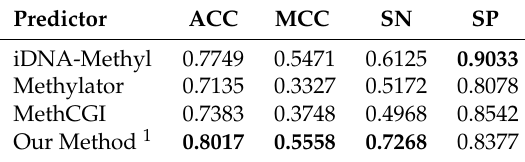
Table 3. Comparison of our method, MethCGI, Methylator, and iDNA-Methyl on the benchmark